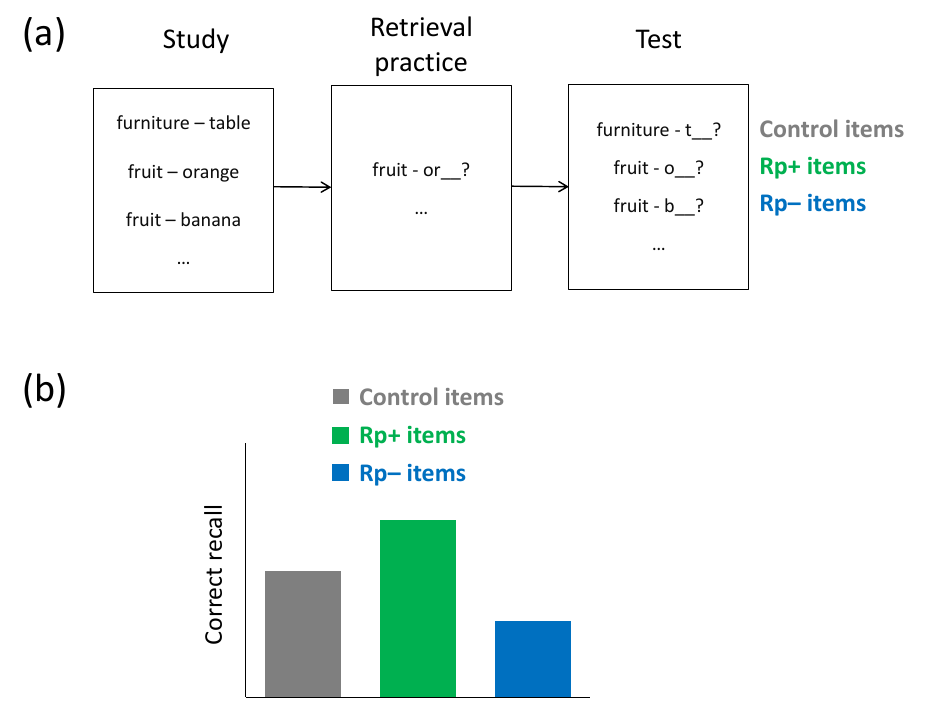
Figure 5. Retrieval-practice task. ( a ) Typical task: Participants first study items from different semantic categories before they are asked to retrieve repeatedly a subset of the exemplars from a subset of the categories. This retrieval practice creates three types of items: items from unpracticed categories (control items), practiced items from practiced categories (Rp+ items), and unpracticed items from practiced categories (Rp − items). On a final retention test, participants are asked to recall all items from the initial study phase. ( b ) Typical results: Recall of Rp+ items is often improved relative to control items, and recall of Rp − items is typically impaired relative to control items, reflecting retrieval-induced